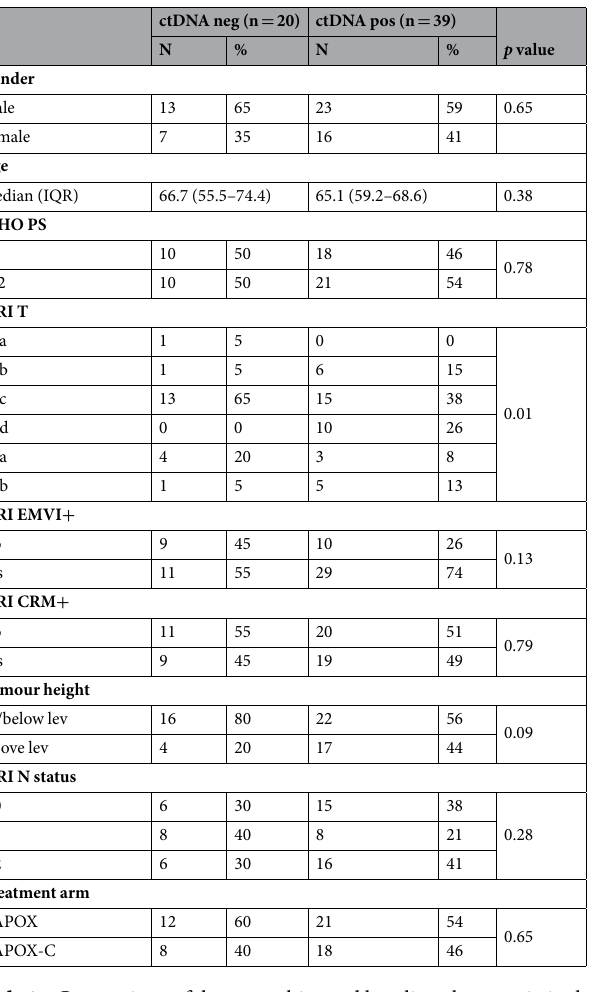
Table 2. Comparison of demographics and baseline characteristics between KRAS mutant/ctDNA negative patients (n = 20) and KRAS mutant/ctDNA positive patients (n = 39). Abbreviations: WHO: World Health Organisation; PS: performance status; MRI: magnetic resonance imaging; EMVI: extramural venous invasion; CRM: circumferential resection margin; lev: levator